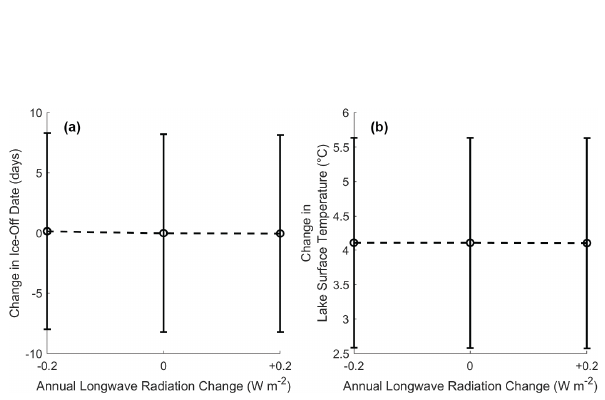
Figure A3. Lake model sensitivity tests showing the effect of an- nual longwave radiation perturbations on (a) ice-out dates and (b) lake water temperatures on 1 May.